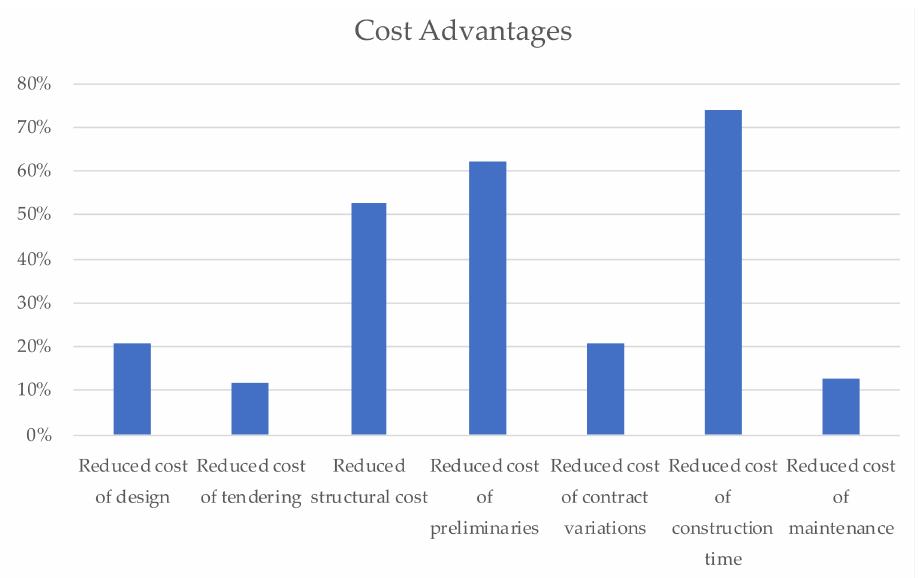
Figure 5. Responses to the question ‘Which of the following do you consider a cost advantage associated with the use of timber in multi-storey